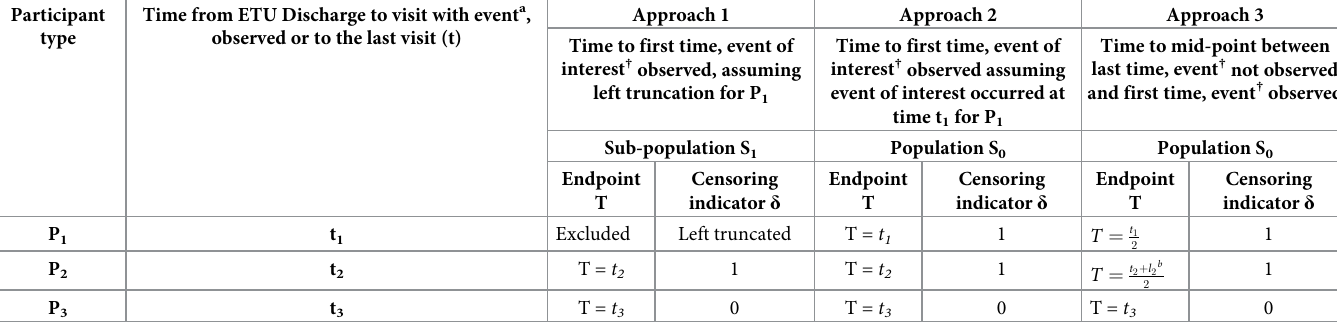
Table 1. Right censored survival methods: The time duration from ETU discharge to confirmed EBOV negativity (T i ) and the censoring status ( δ i ) for populations S 0 and S 1 , and by type of